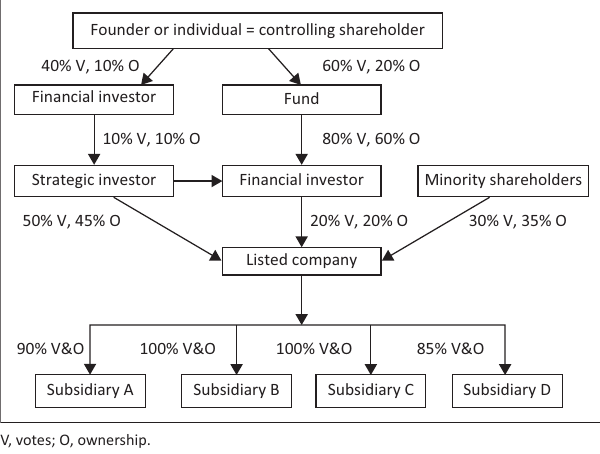
FIGURE 1: A model of a